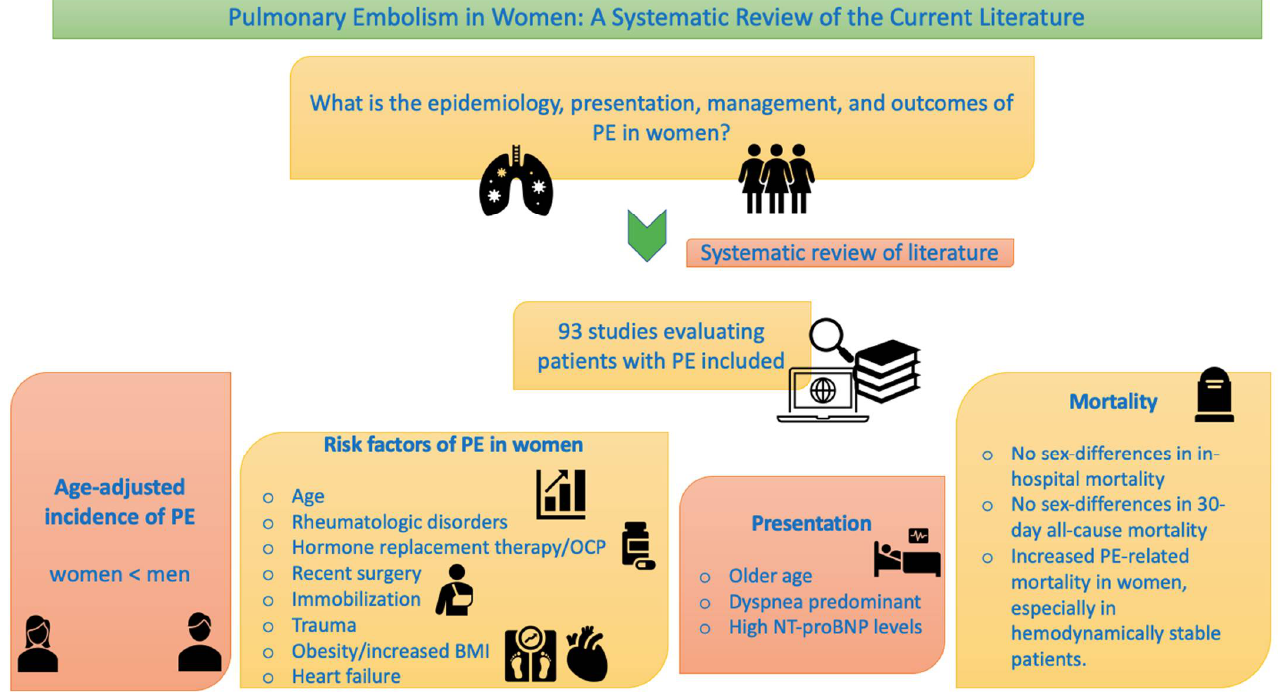
Figure 2. Characteristics of pulmonary embolism in women.